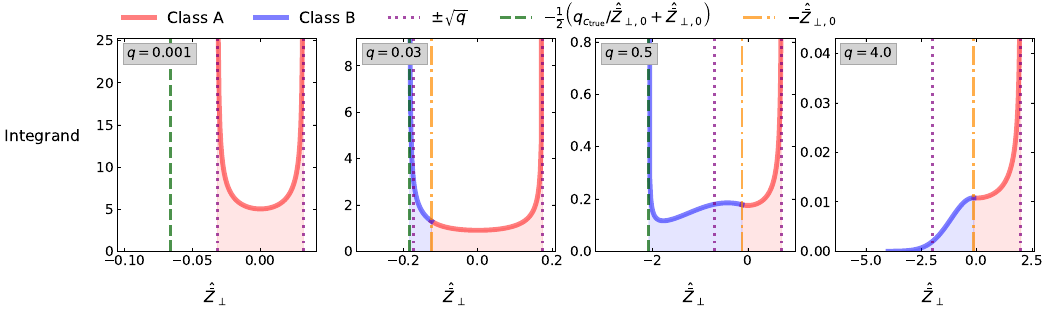
(cid:0) (cid:1) q for four different values of q q c true